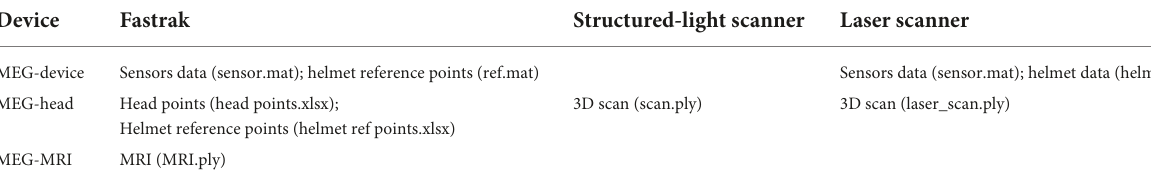
TABLE 1 Input data during